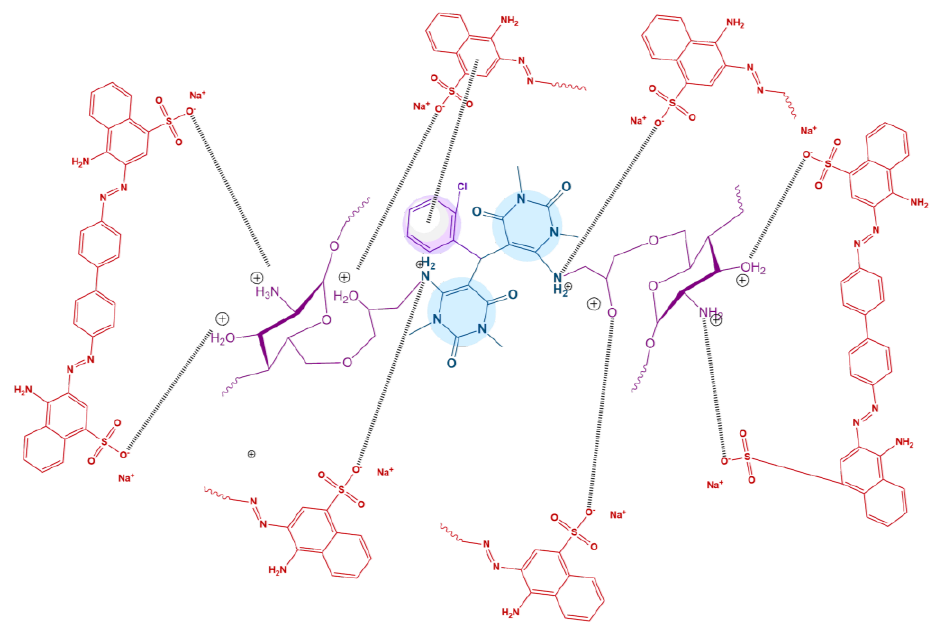
Figure 23. Schematic illustration of the interaction of CR dye with 2Clph-BU-Cs adsorbent.